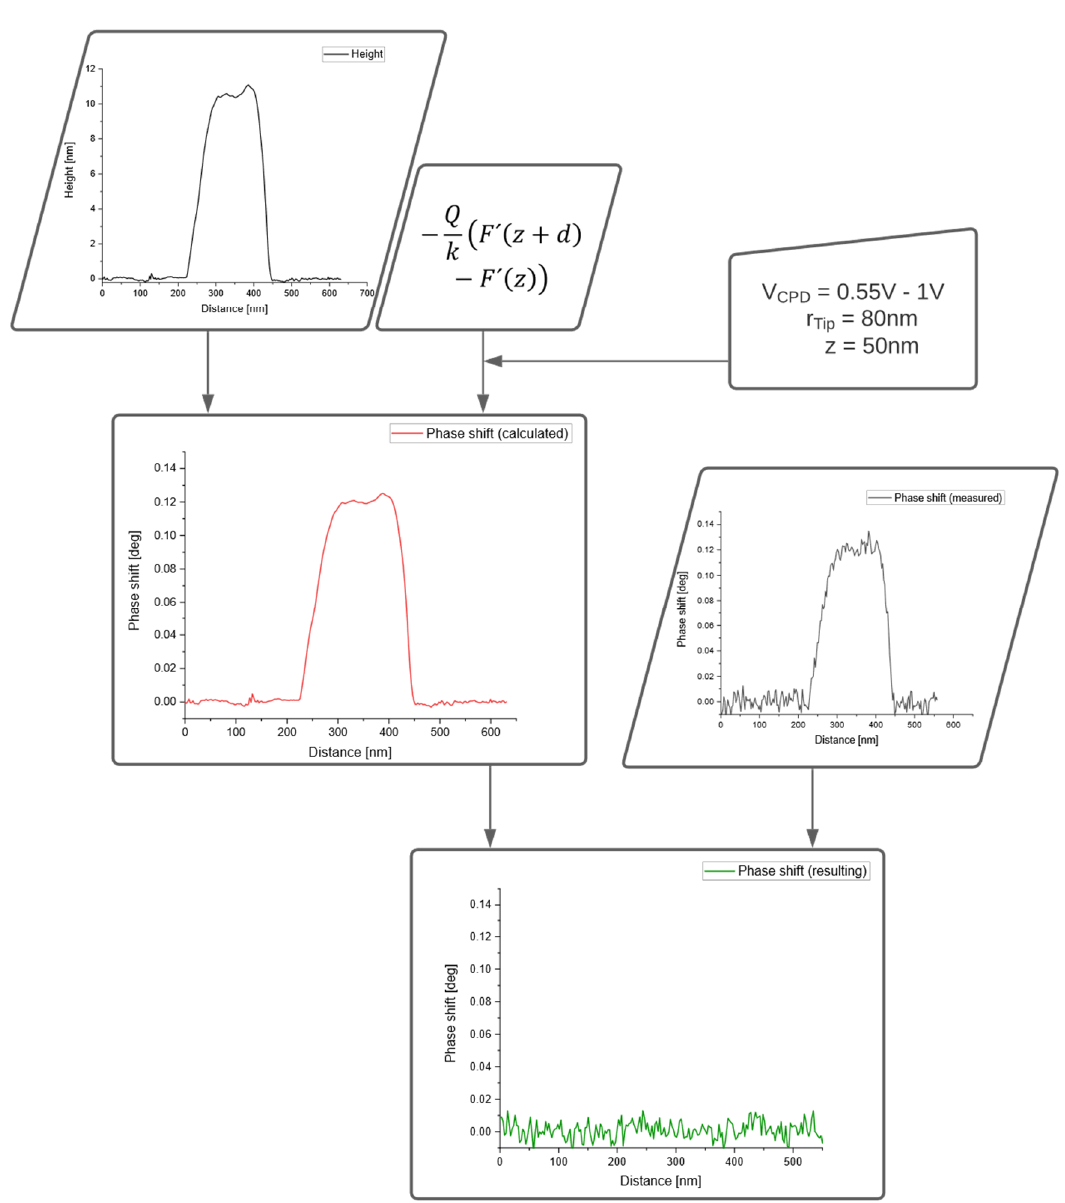
Figure 3. Data fusion of AFM topography and Magnetic Force Microscopy (MFM) phase image for polystyrene nanoparticles.